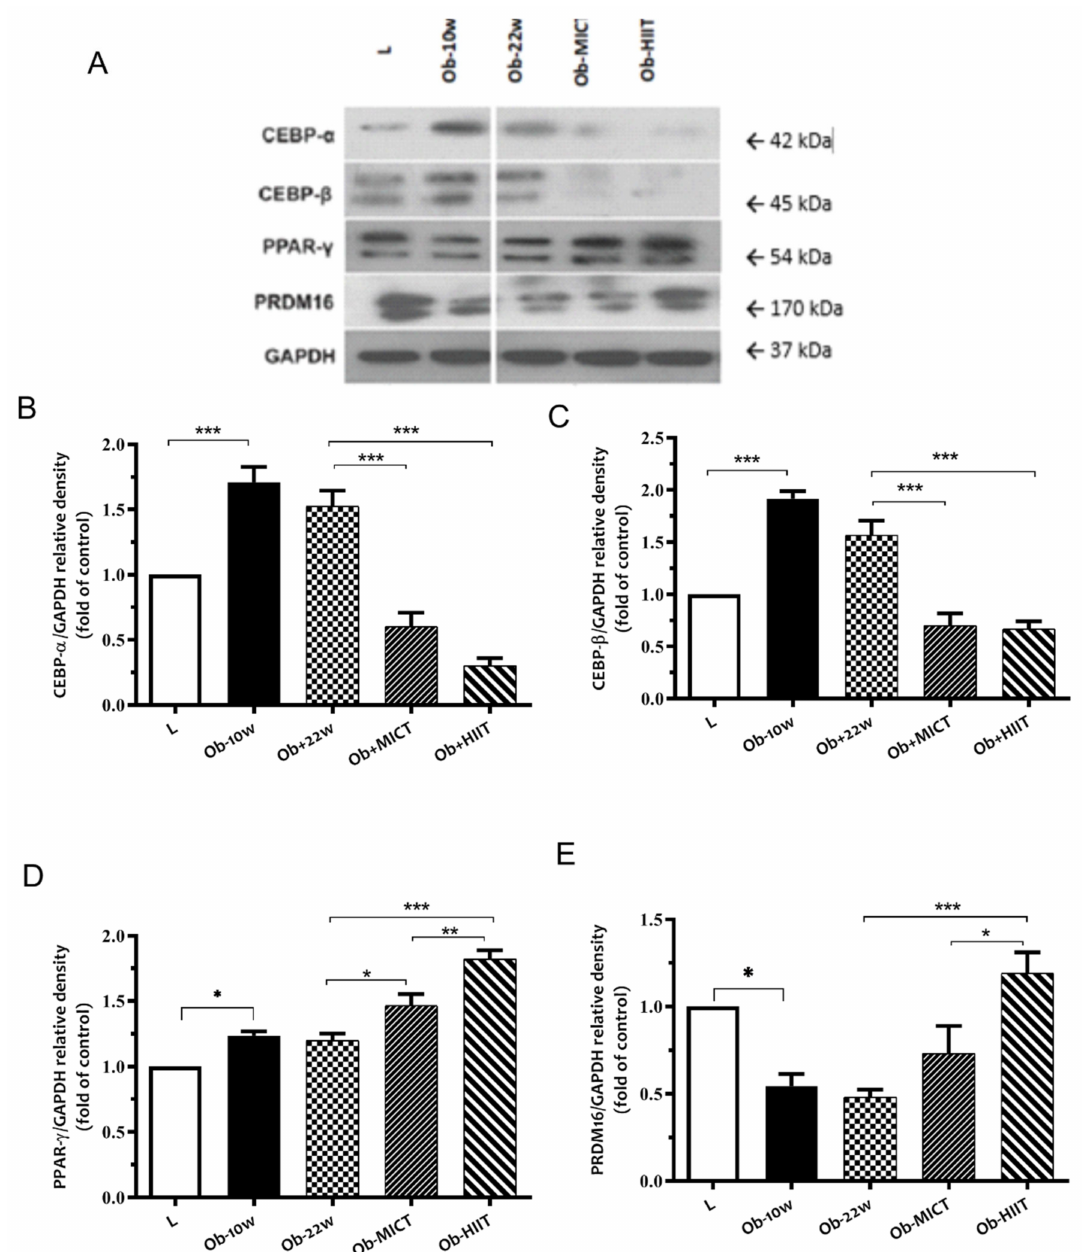
Figure 3. The e ff ect of obesity and exercise training on markers of white adipocyte di ff erentiation in subcutaneous adipose tissue. ( A ) Western blot analysis of protein expression for C / EBP- α , C / EBP- β , PPAR- γ , PRDM16, and GAPDH. Quantification graphs of ( B ) C / EBP- α , ( C ) C / EBP- β , ( D ) PPAR- γ , and ( E ) PRDM16 relative to GAPDH. Data are represented as means ± SEM ( n = 6) and significant di ff erence between groups indicated by * p < 0.05, ** p < 0.01, *** p < 0.001. L: lean; Ob-10w: obesity-10 weeks; Ob-22w: obesity + sedentary; Ob-MICT: obesity + moderate-intensity continuous training; Ob-HIIT: obesity + high-intensity interval training